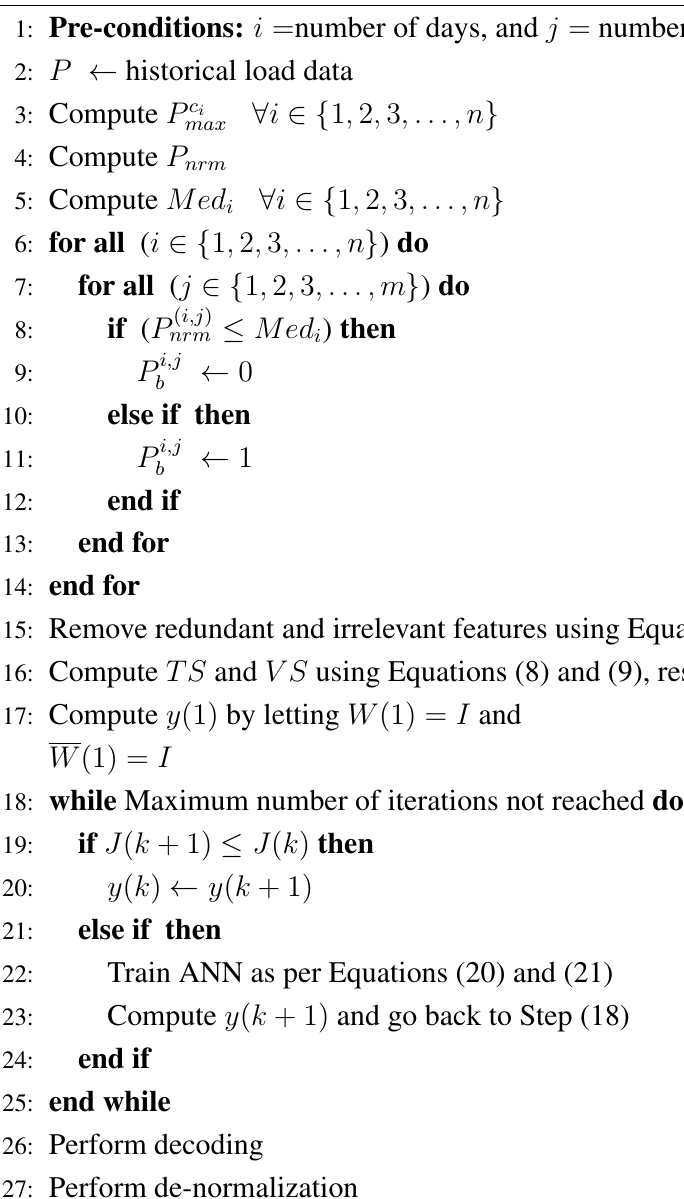
Algorithm 1 Day-ahead load